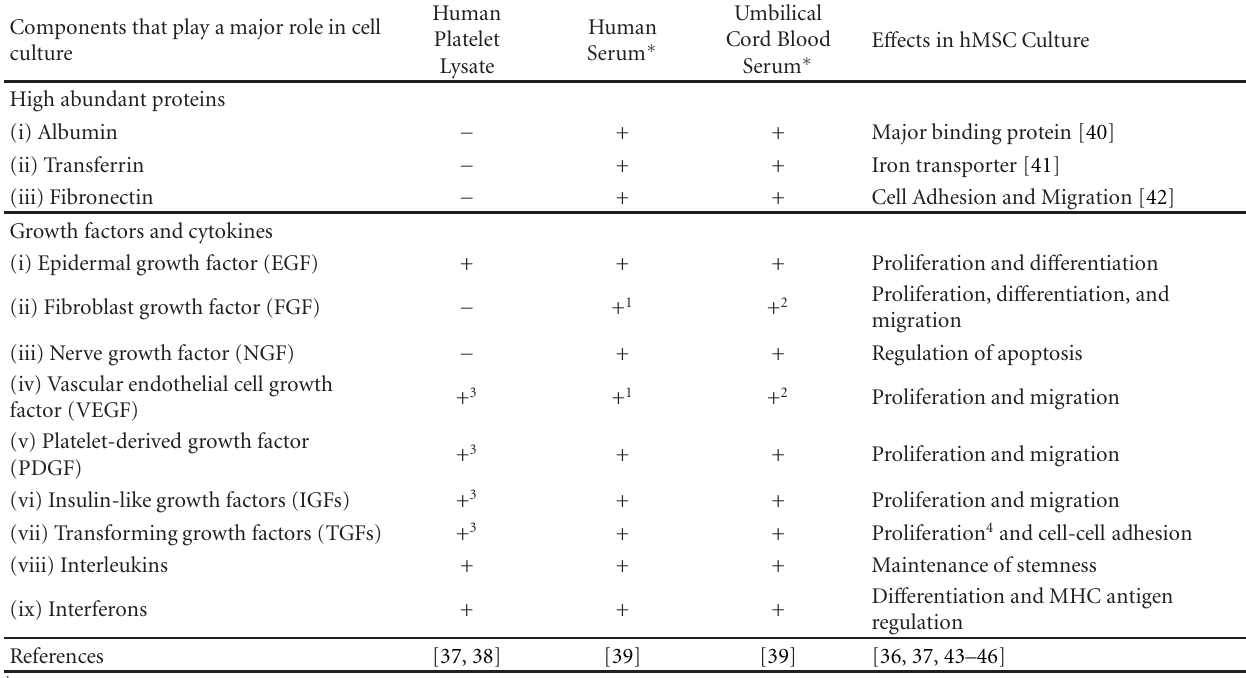
Table 2: Comparison between the general components of serum and human platelet lysate and their e ff ect on hMSC culture. Components that play a major role in